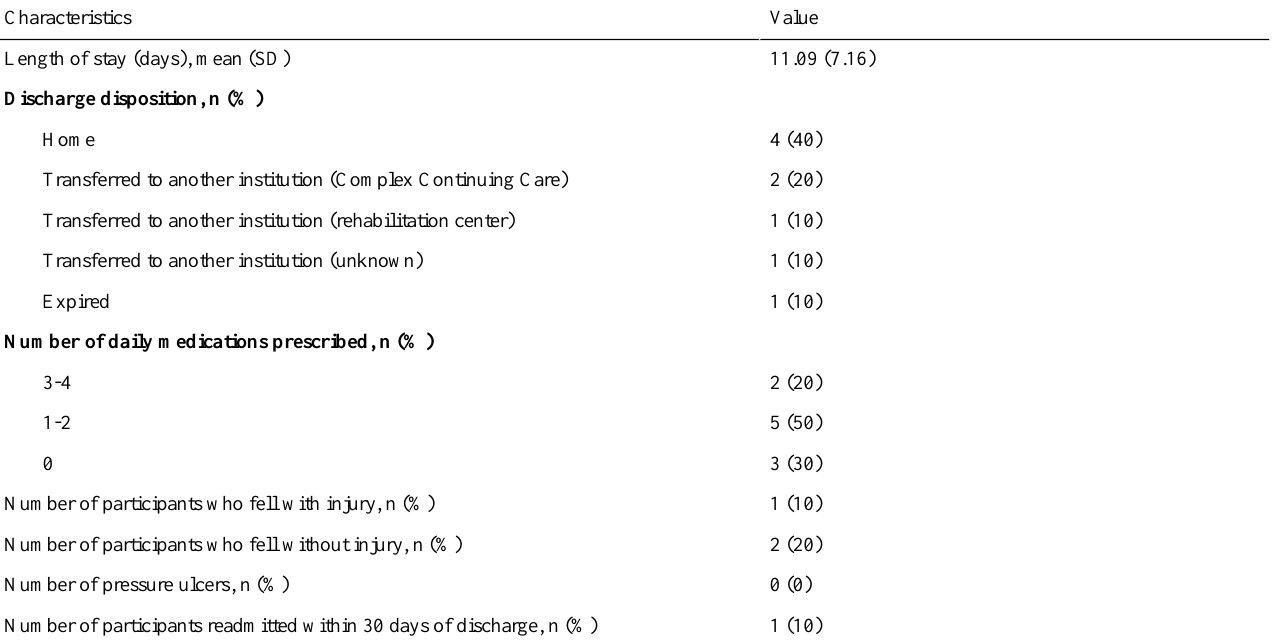
Table 2. Factors related to hospital stay